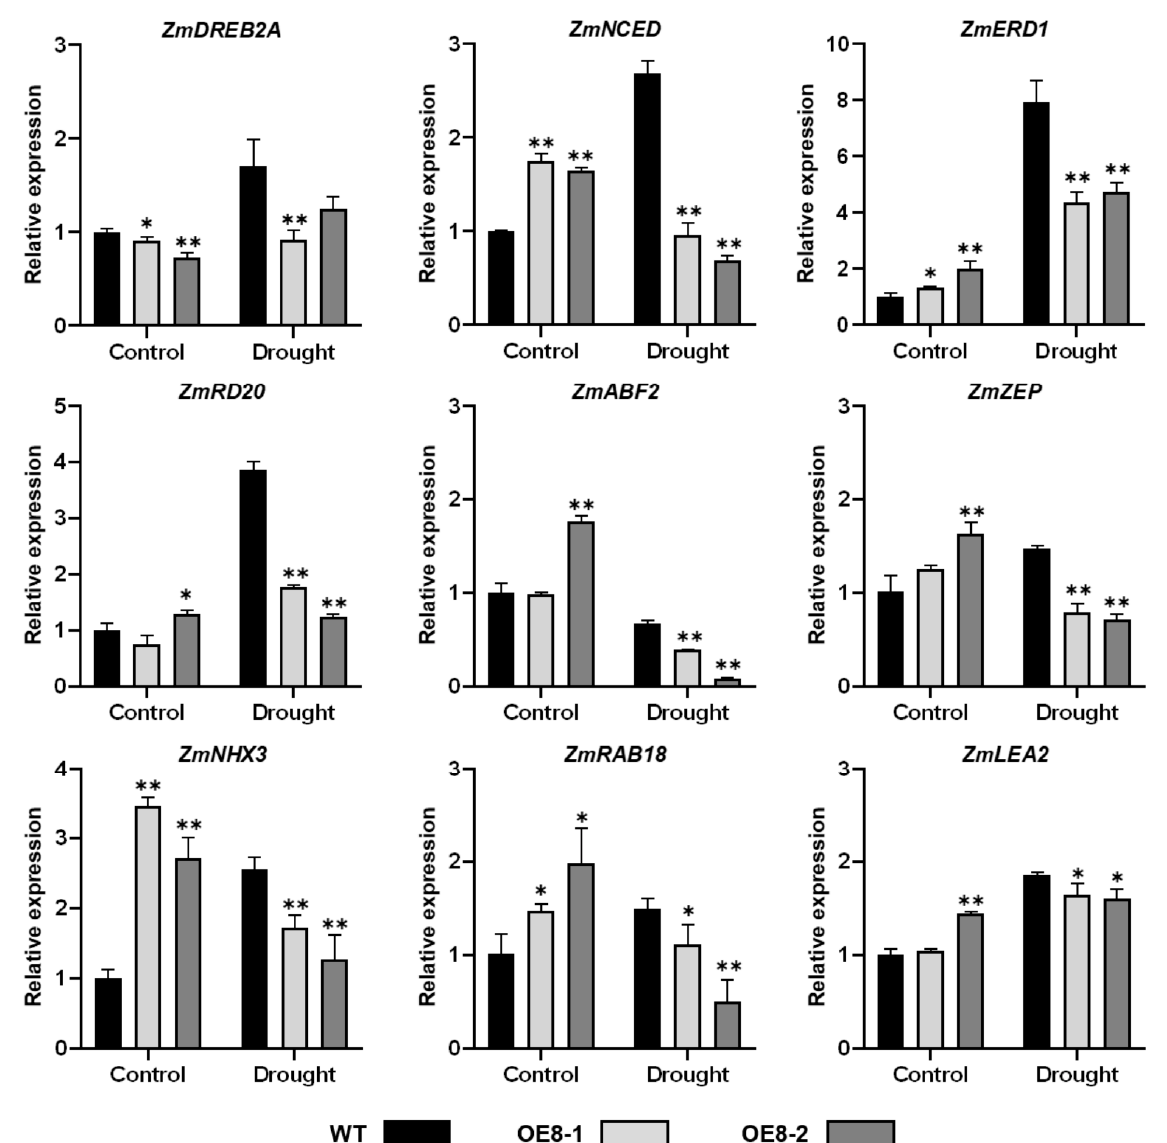
Figure 7. Expression levels of stress-responsive genes in WT and ZmHsf08 -overexpressing plants under normal condition and drought treatment. Three-leaf stage maize seedlings were withheld water for 7 days. The expression levels of stress- responsive genes during drought stress were analyzed by RT-qPCR. Values are means ± SD. Bars represent means ± SD ( n = 3 repeats). Significant differences (Student’s t test): *, p < 0.05, **, p < 0.01.